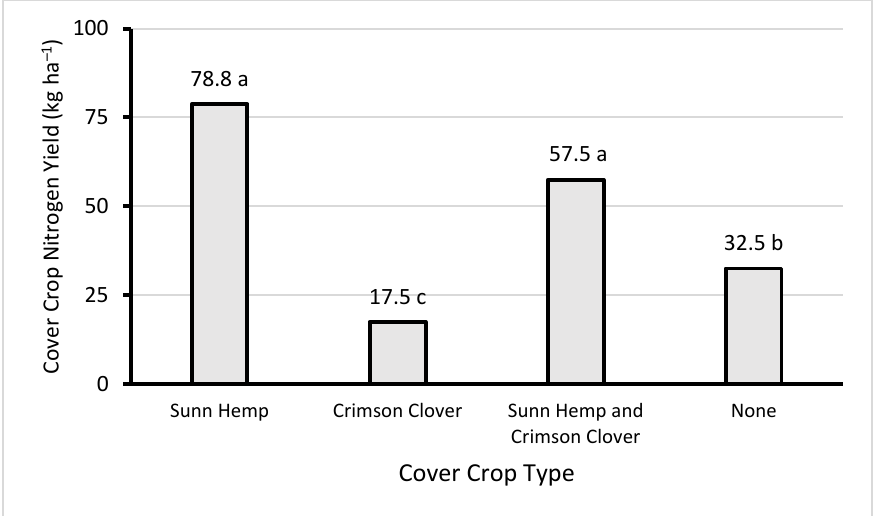
adjusted t-tests at p ≤ 0.05.